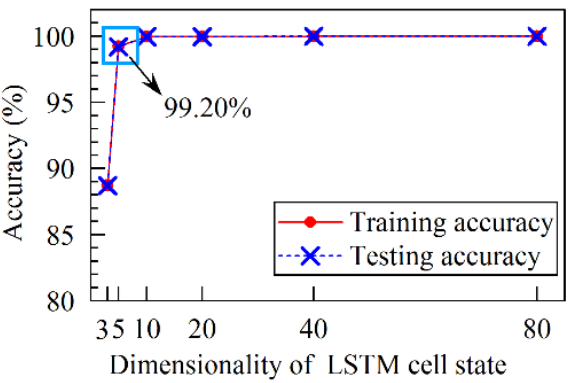
Figure 12. Training and testing accuracies of the second network structure and division mode 1. The cyan circle marks the accuracy that is more than 95% with the lowest hidden element number.